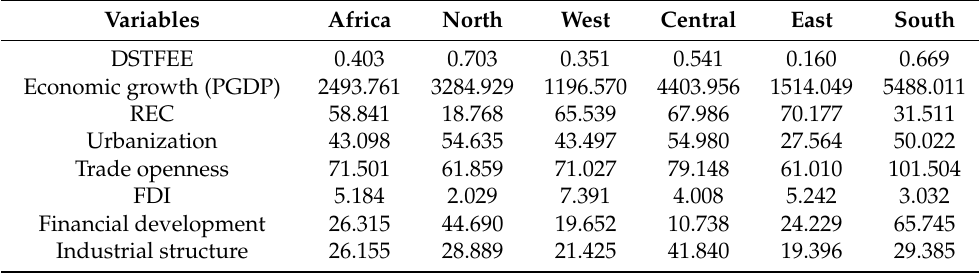
Table 4. Summary statistics of the determinants of DSTFEE across the regions in Africa.